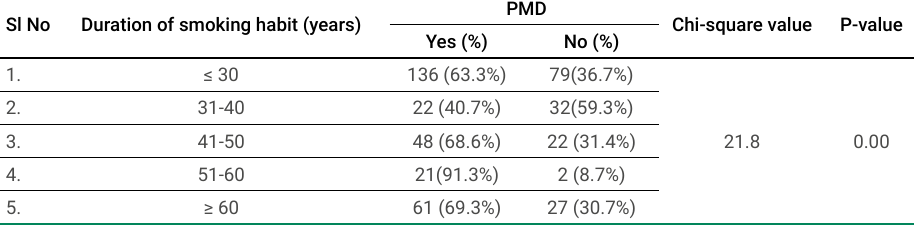
Table 4. Distribution of subjects according to duration of smoking and PMD Sl No Duration of smoking habit (years)